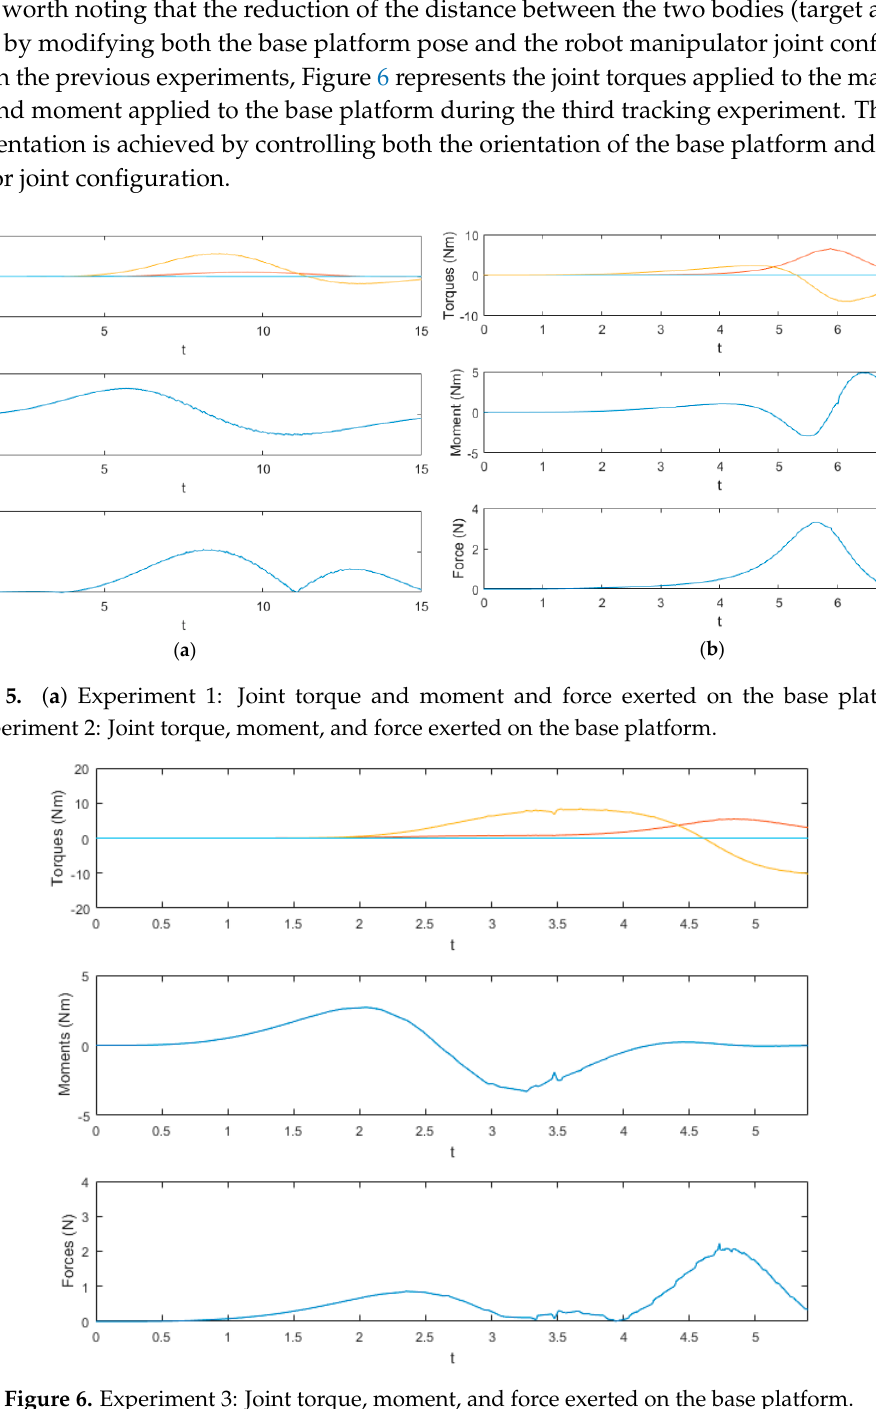
Figure 6. Experiment 3: Joint torque, moment, and force exerted on the base platform.